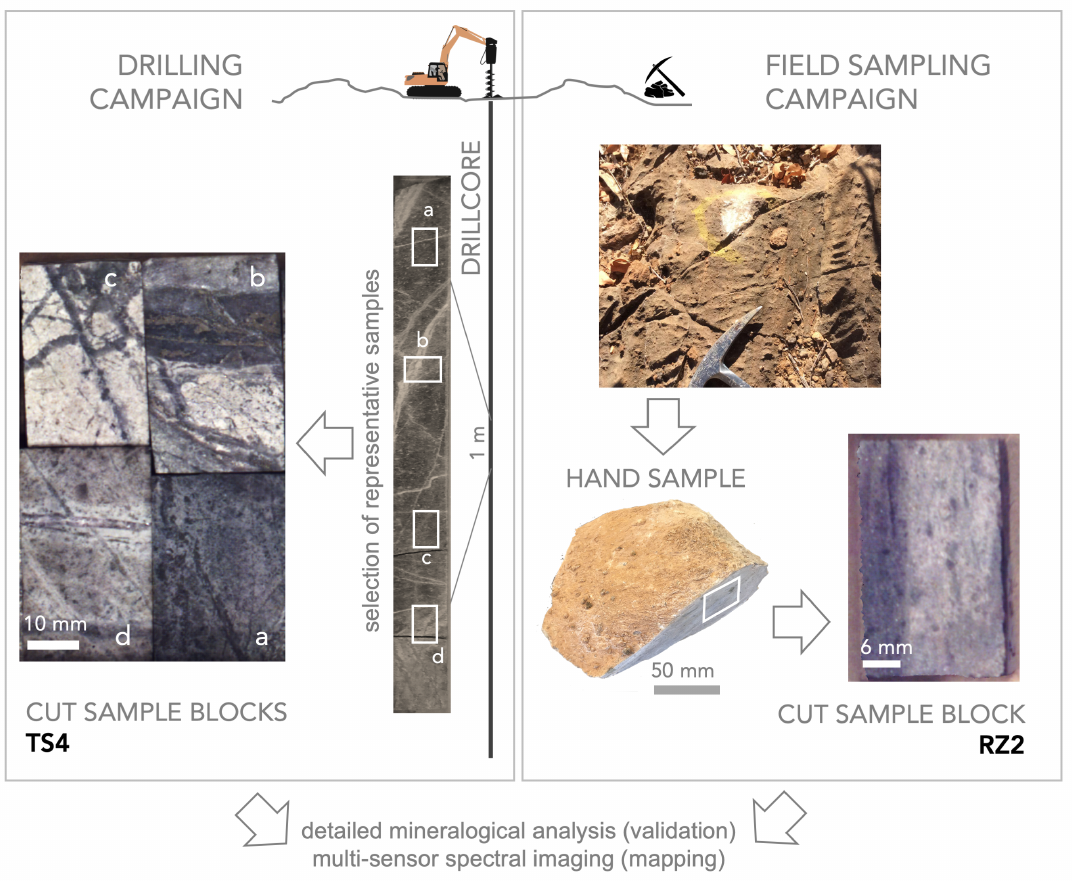
Figure 2. Schematic overview of the samples analyzed. ( left ) Selected representative drillcore sample blocks TS4, ( right ) sample block RZ2 from a field sampling